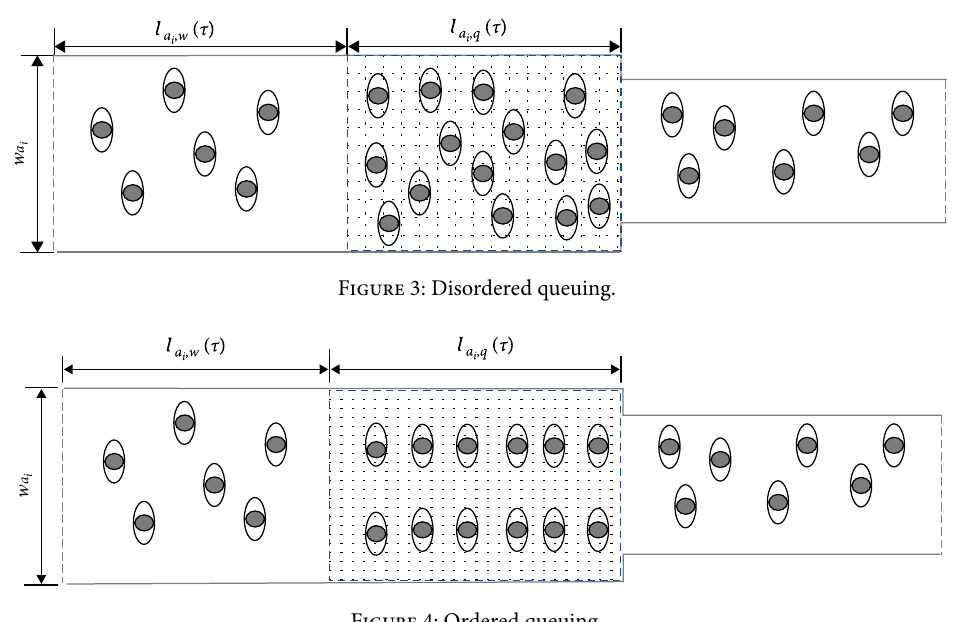
Figure 4: Ordered